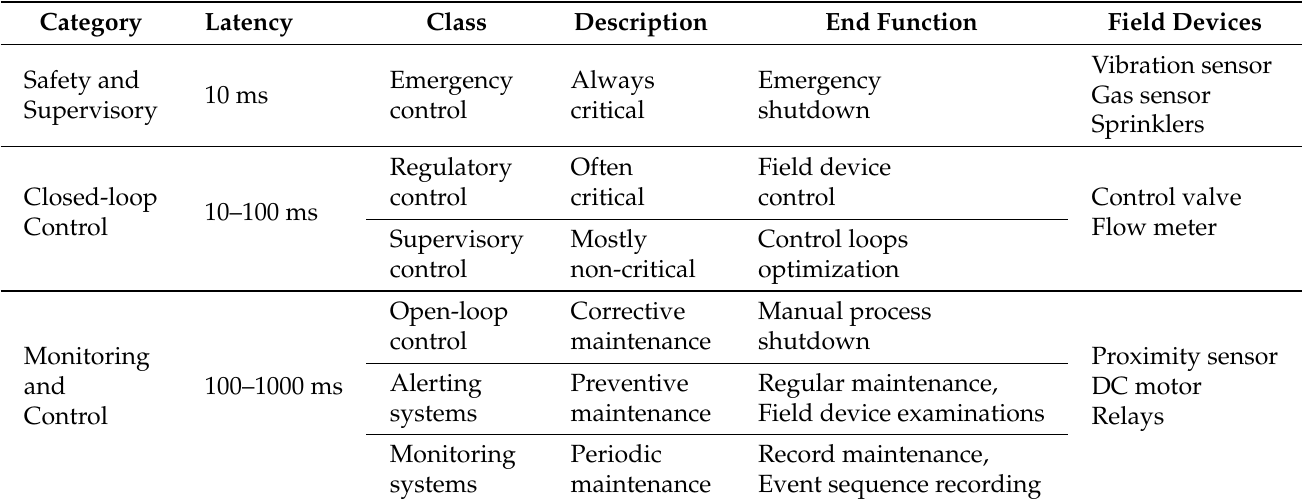
Table 3. Classes of industrial process